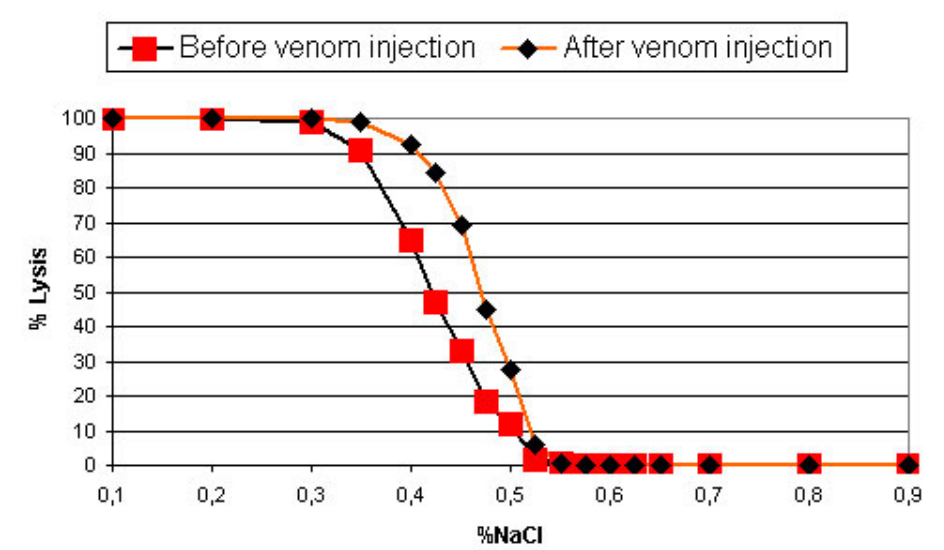
Figure 1: In vivo effect of O. doriae venom (0.5 mg/kg, IV) on the osmotic fragility of RBCs after incubation for 30 minutes.